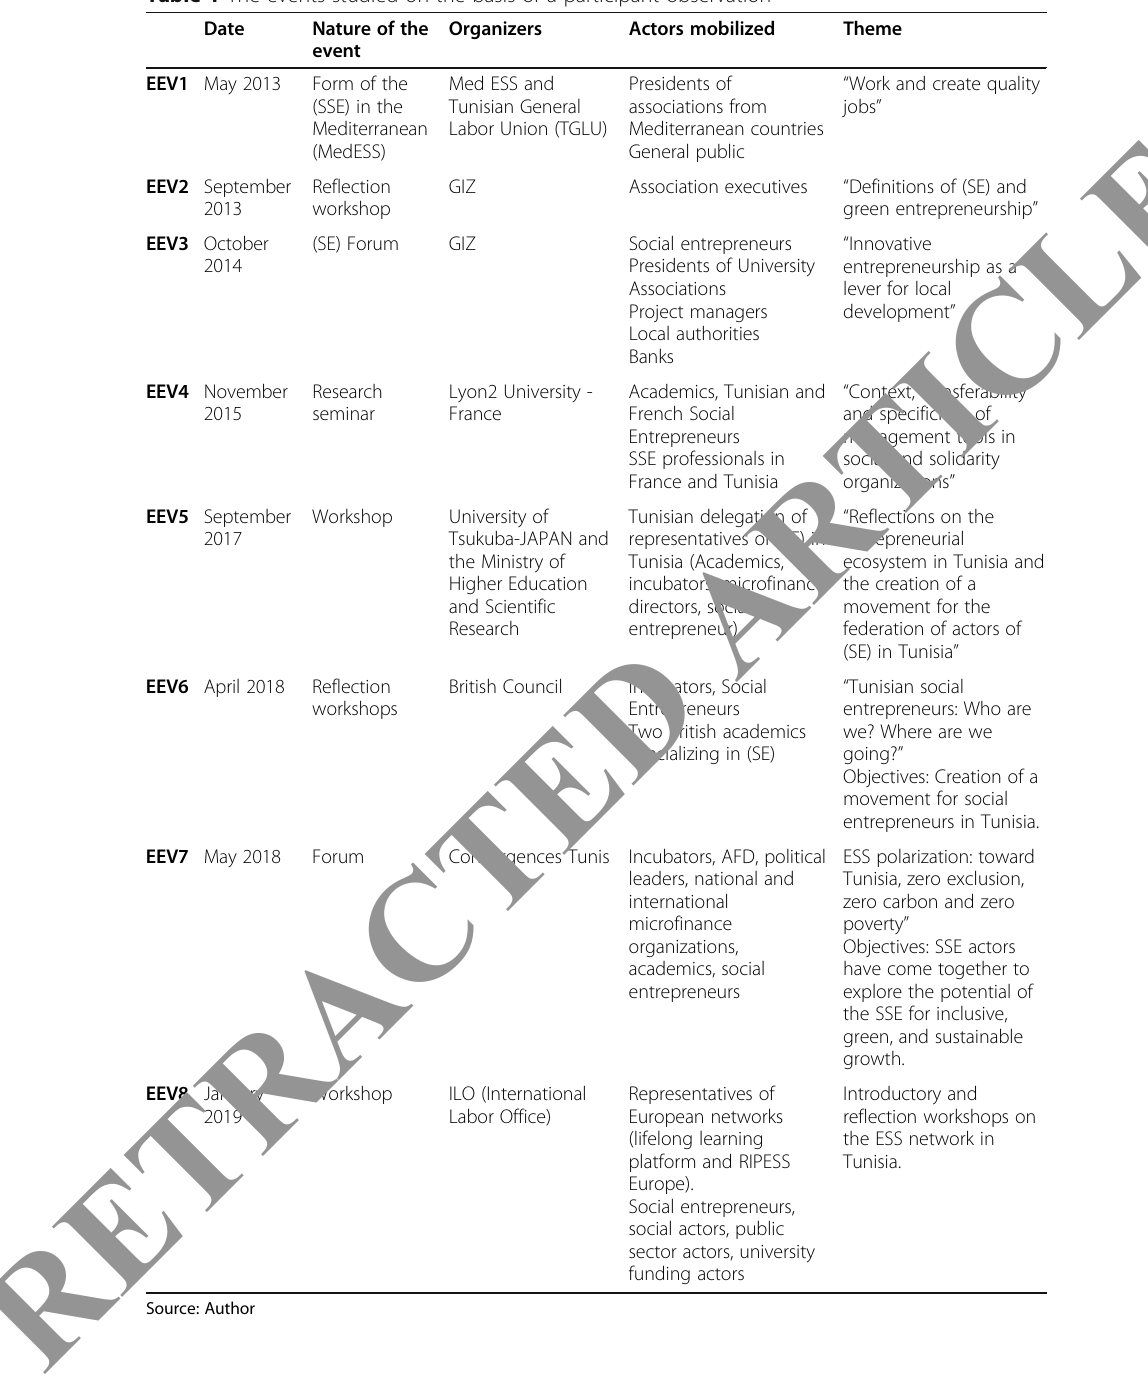
Table 1 The events studied on the basis of a participant